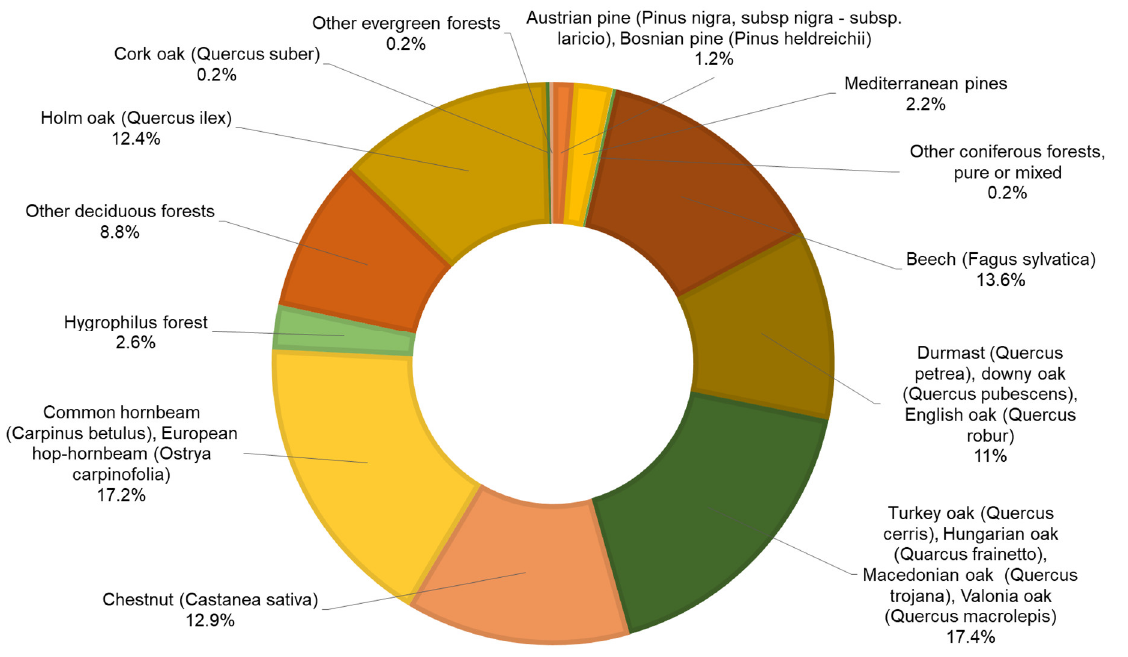
Figure 1. Forest typologies in the Salerno province by surface (percentages of the total forest area).